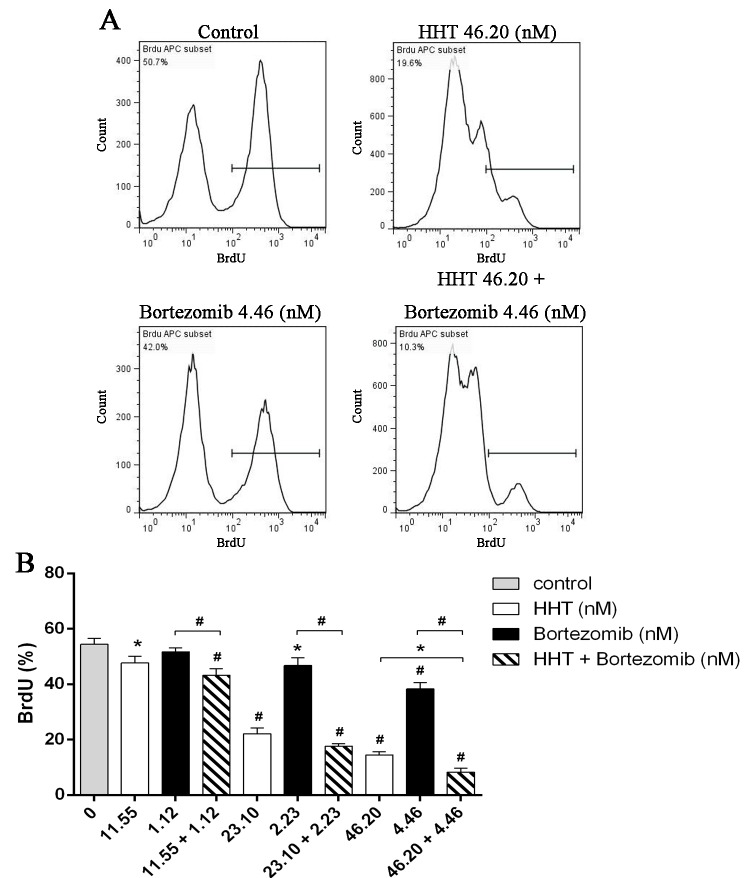
Simultaneous exposure to HHT and Bortezomib resulted in a significant reduction of cell proliferation.(A) SKM-1 cells treated with 46.20 nM HHT, 4.46 nM Bortezomib or 46.20 nM HHT + 4.46 nM Bortezomib simultaneously for 72 h. (B) SKM-1 cells treated with HHT (11.55, 23.10, 46.20 nM) or Bortezomib (1.12, 2.23, 4.46 nM) for 72 h. Concurrently, simultaneous treatment experiments were conducted at molar ratio of 10.4: 1. Bar graph of BrdU positive rates.*P < 0.05, #P < 0.01 vs untreated control.